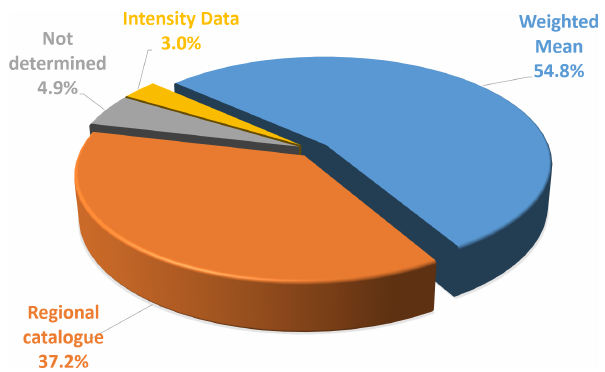
Figure 8. Histogram of magnitude values in EPICA according to 0.5 M w bins and their type (reassessed from intensity data, re- assessed from a regional parametric catalogue, weighted mean of the two reassessments; see also Figs. 7 and